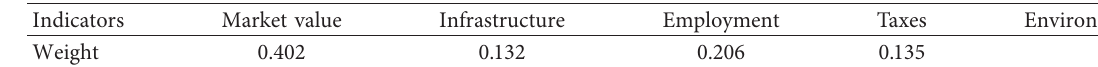
Table 4: Summary of weights.